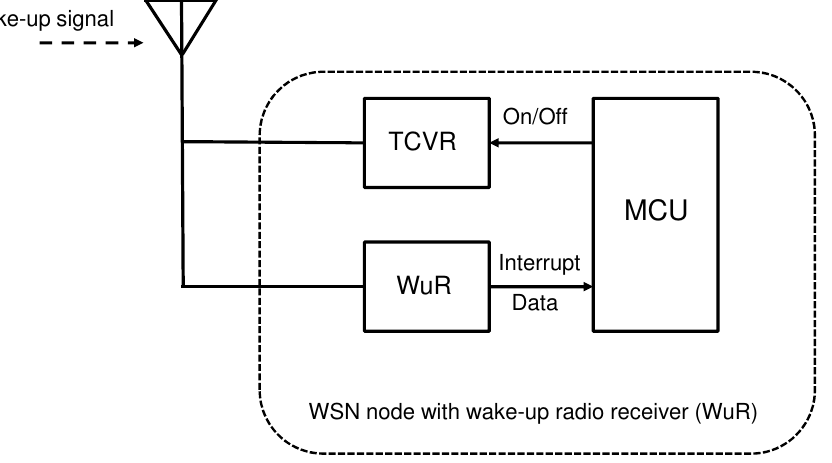
Figure 4. Wake-up Radio (WuR) within wireless sensor node